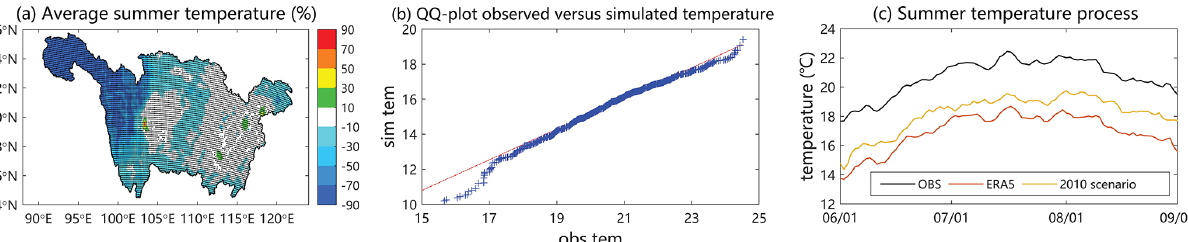
Figure 6. (a) The biases of average summer temperature (%) between the 2010 scenario and observed data; the stippled regions show statistically significance of bias identified by t test at a 5% significance level. (b) The q–q plot of observed temperature versus simulated temperature. (c) The basin-averaged summer temperature processes of the observation, ERA5, and the 2010 scenario.